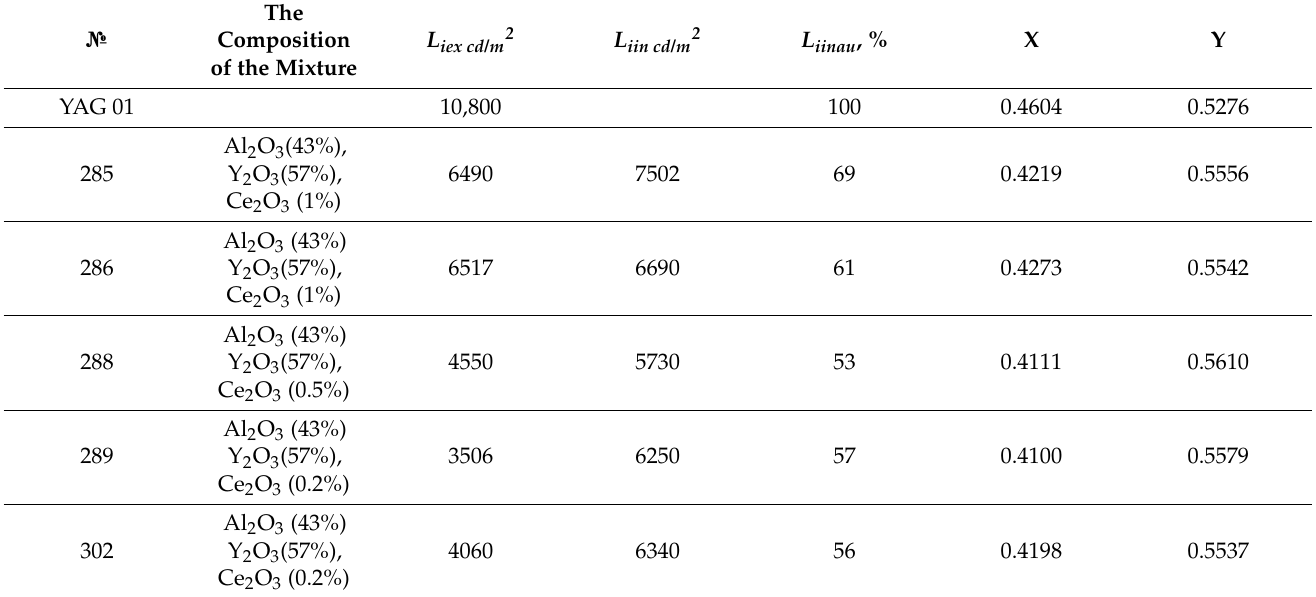
Table 2. Brightness and luminescence color coordinates of ceramic